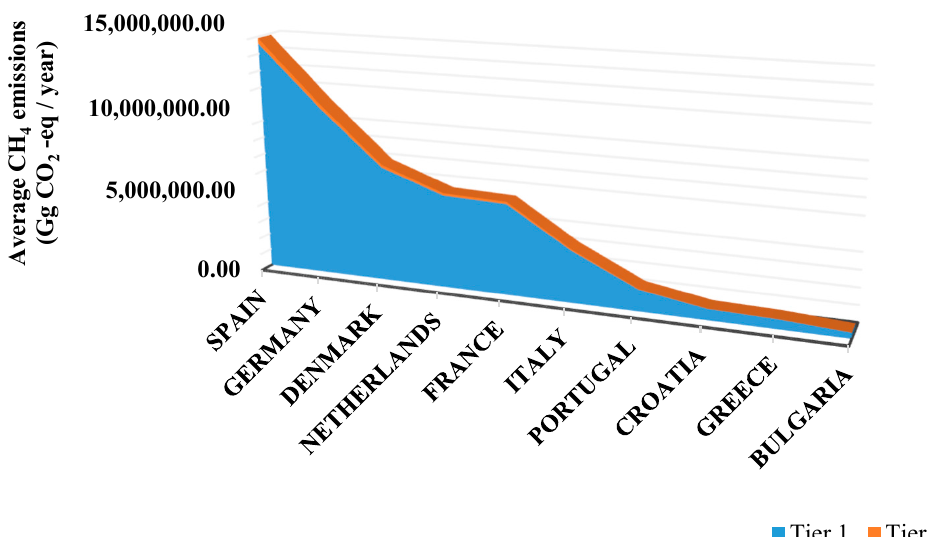
Figure 1. Comparison of mean CH 4 emissions from manure management using Tier 1 and 2 method- ologies (Gg CO 2 -eq/year). The different thickness of each graph (blue or red) represents the estimated emission by the two methodologies.